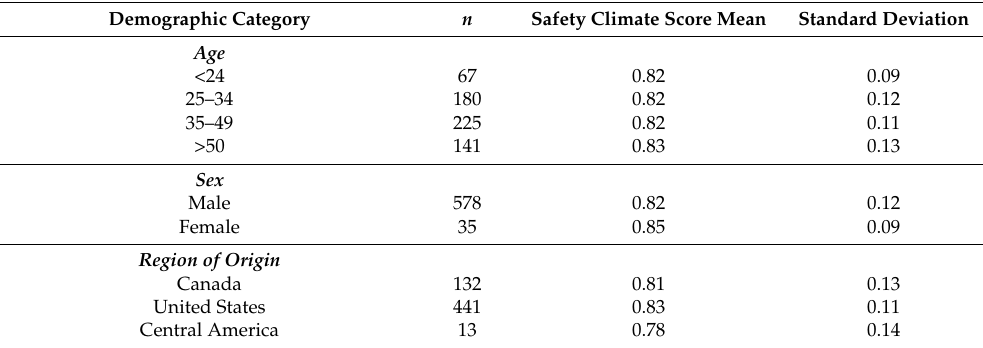
Table 2. Participant